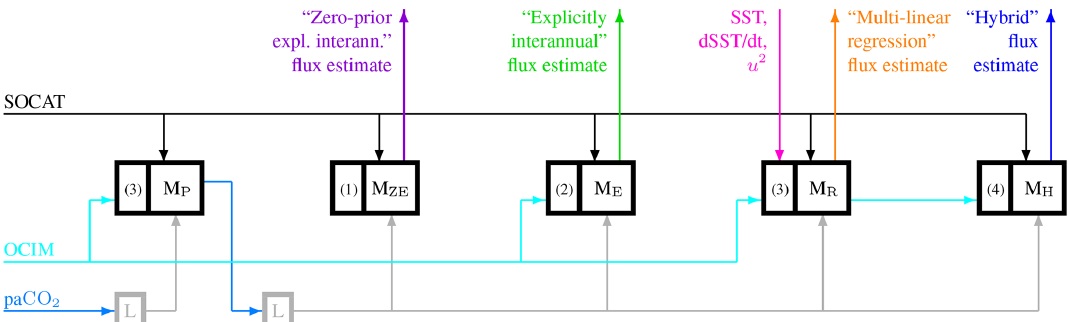
Figure 2. Information flow between the presented mapping runs. Thick-framed boxes denote calculations, with arrows denoting their input and output data sets (mostly spatio-temporal fields). The violet, green, orange, and blue arrows represent the spatio-temporal sea–air CO 2 fluxes estimated by our main mapping runs M ZE , M E , M R , and M H (these same four colours are also used in all line plots in this paper). All mapping runs use the SOCAT database of p CO 2 measurements (point data, black) as their primary information source. The runs are algorithmically identical, except for the representation of the ocean-internal DIC sources and sinks ( f int ) and the corresponding set of adjustable unknowns; this part of the mapping algorithm has therefore been represented explicitly as separate parts of the boxes at their left- hand sides, labelled by the respective equation number. Runs M ZE and M E are using the representations with explicit interannual degrees of freedom, either without f int prior (Eq. 1) or using the decadally smoothed OCIM result as f int prior (cyan; Eq. 2). Run M R is using the representation involving regression terms (Eq. 3), which requires the explanatory variables (magenta) as further input fields; it uses the same f int prior as the run M E . The representation of f int in the “hybrid” run M H again has explicit interannual degrees of freedom but no long-term and seasonal degrees of freedom (Eq. 4). Importantly, it uses the ocean-internal DIC sources and sinks estimated by the “multi- linear regression” M R as its f int prior (cyan again). All mapping calculations use the various input fields shown in Fig. 1, which are however omitted here for clarity. More technically, the mappings also need a linearization of the non-linear dependence of p CO 2 on DIC, consisting of three fields (the derivatives d p CO 2 / dDIC as well as reference fields for p CO 2 and DIC) together depicted by the grey arrows. Box L denotes the calculation of d p CO 2 / dDIC and the reference DIC field from a reference p CO 2 field (light blue) as described in Sect. 2.1.6 (the further input fields required by this calculation are not depicted). For the main mappings M ZE , M E , M R , and M H , the reference p CO 2 field comes from the data-based estimate of the pre-mapping M P . The linearization for M P , in turn, uses the atmospheric p CO 2 field as p CO 2 reference (light blue